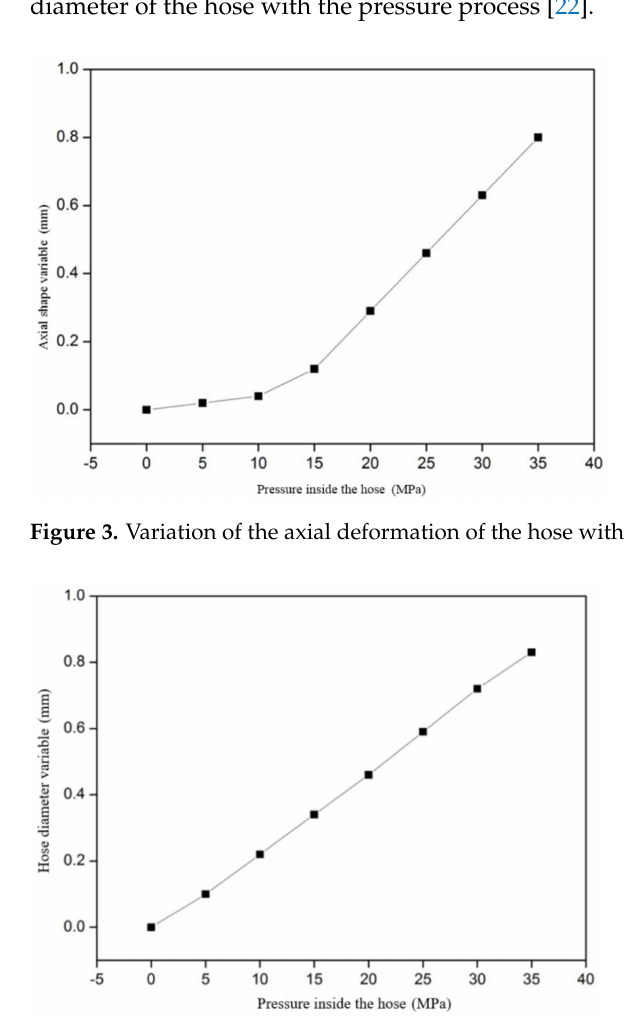
Figure 4. Variation of the inner diameter of the hose with the pressure application